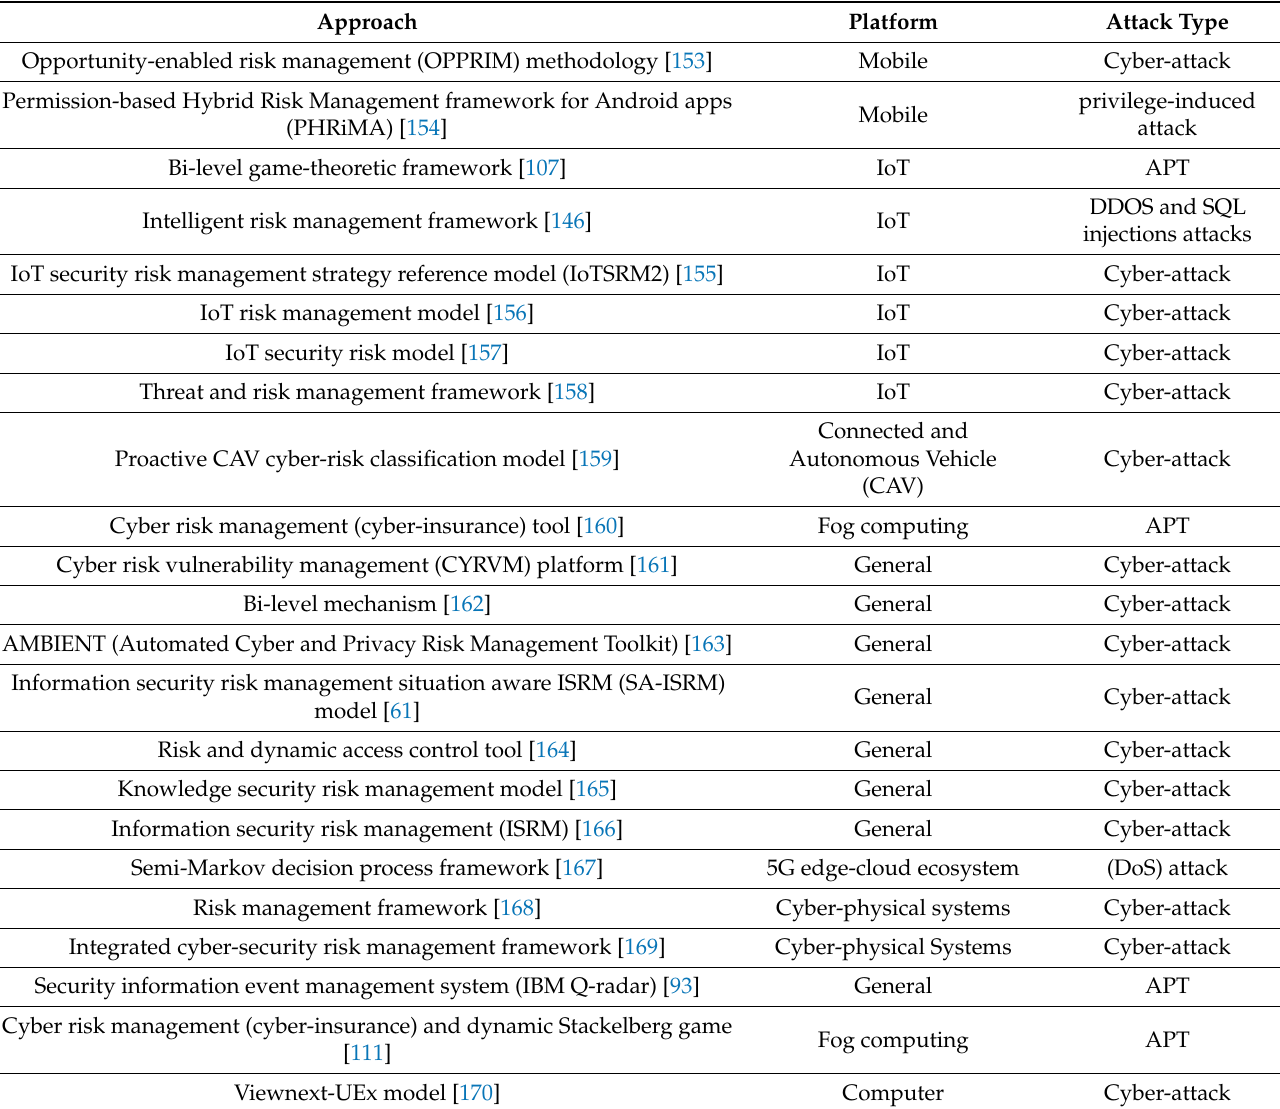
Table 6. Risk management